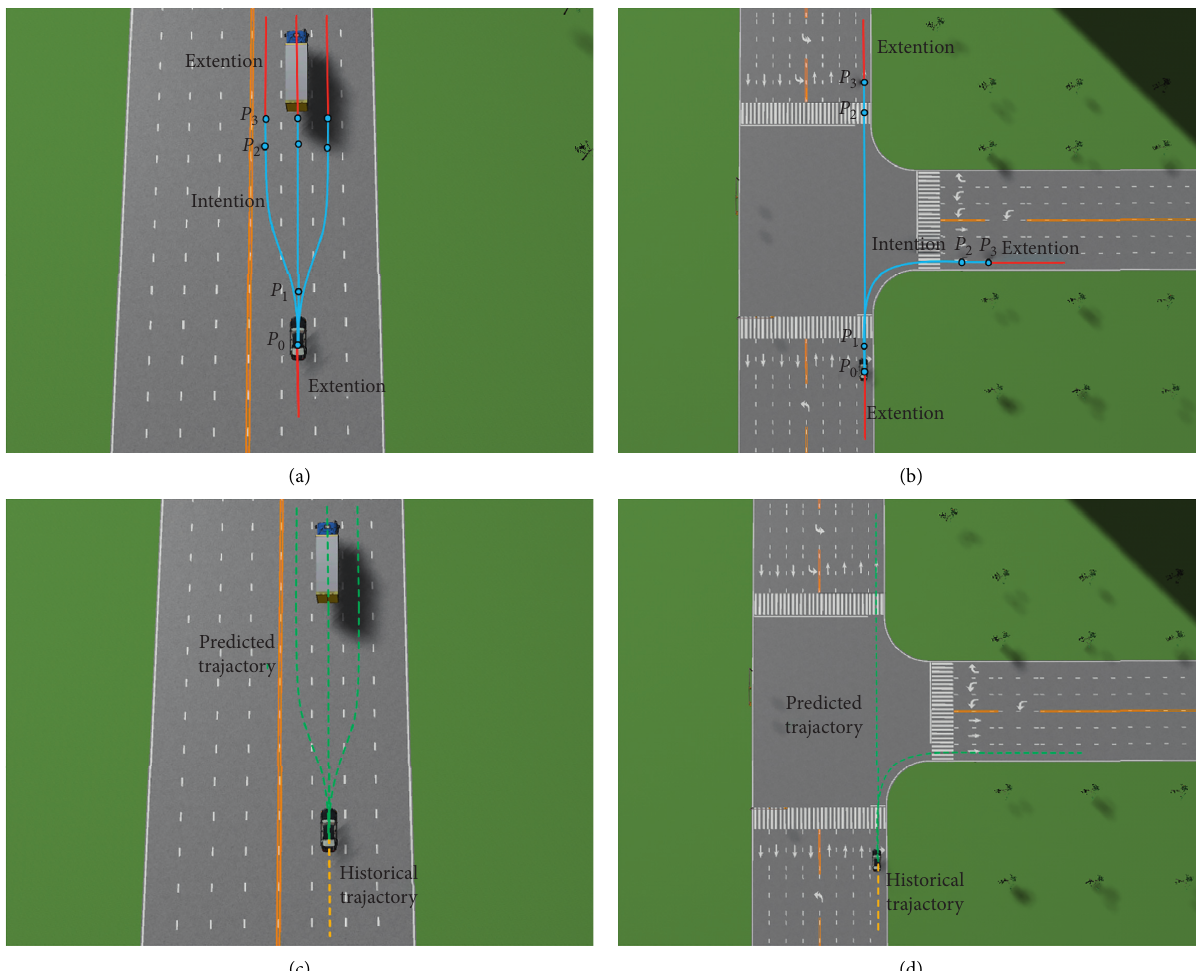
Figure 16: Simulation results: (a) on the road scenario; (b) intersection scenario; (c) simulation results of the on the road scenario; (d) simulation results of the intersection scenario.